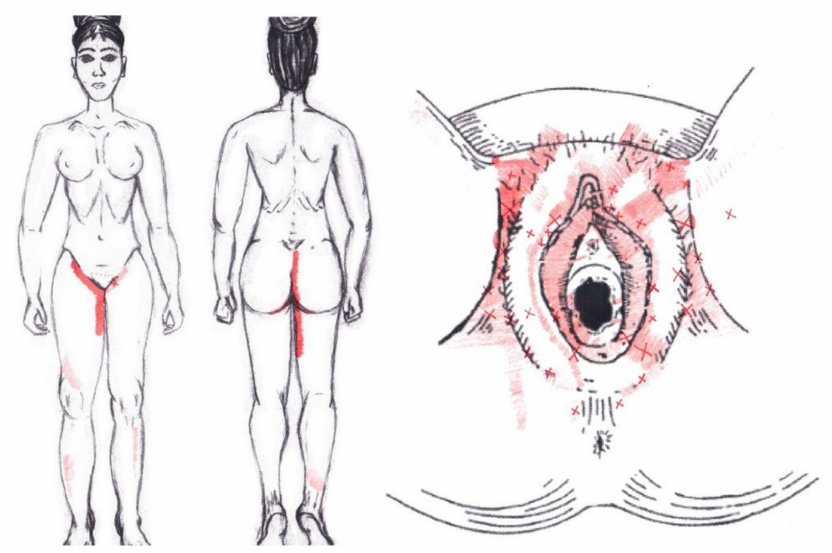
Figure 12. Graphical simulation of referred pain areas of the ischiocavernosus muscle.